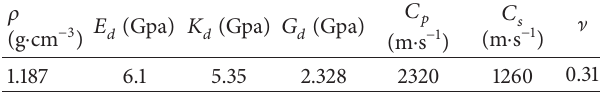
Table 1: Dynamic parameters of PMMA [26].